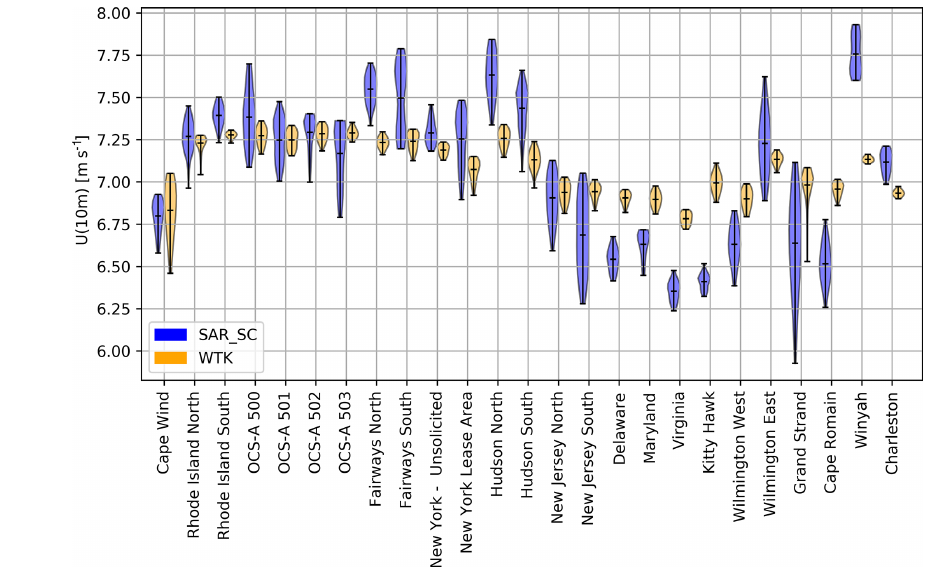
Figure 15. Violin plot for wind speeds from seasonally corrected SAR and WTK. Potential lease sites are ordered from north (left) to south